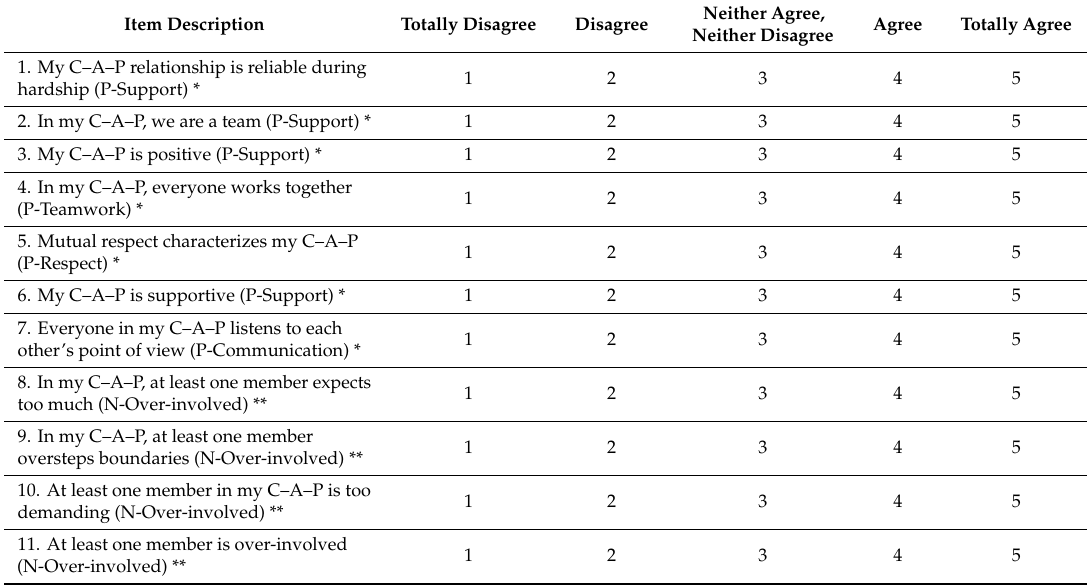
Table 4. Final version of the Positive and Negative Processes in the Coach–Athlete–Parent Questionnaire (PNPCAP) interpersonal relationships of the